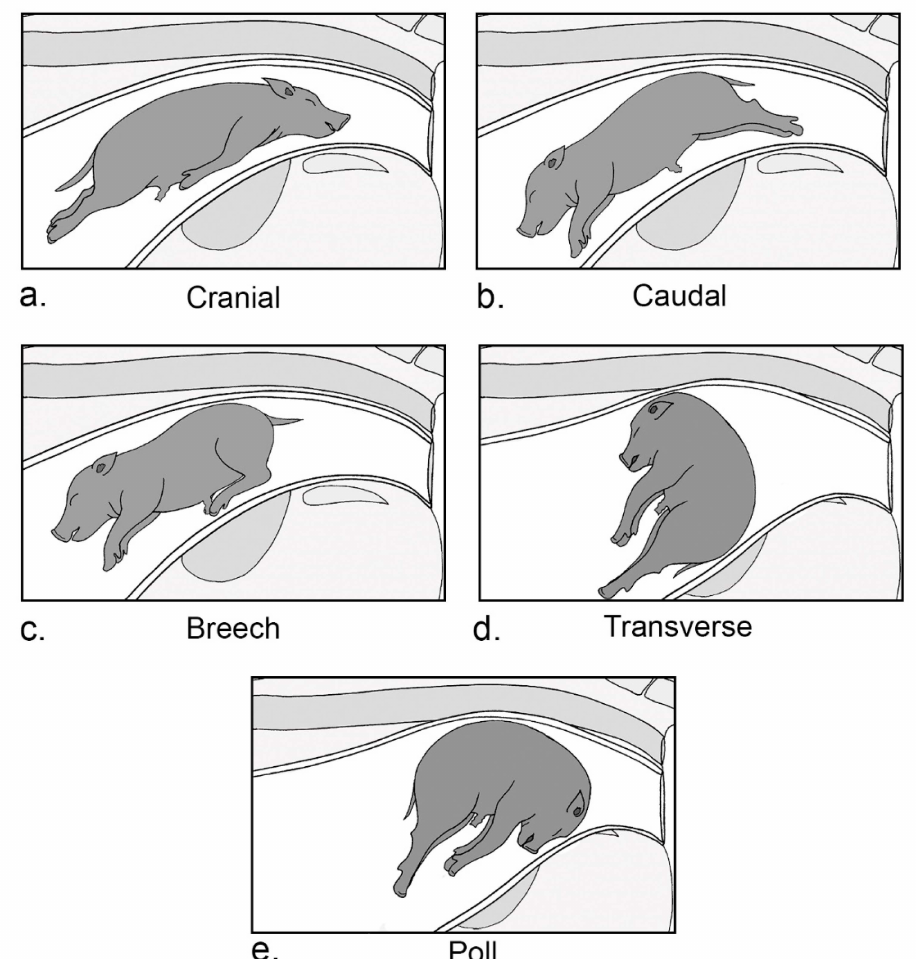
Figure 2. Anatomical piglet positioning within the birthing canal at parturition: ( a ) cranial pre- sentation involving the head exiting first and forelimbs gathered up against the body; ( b ) caudal presentation involving hindlegs first, posteriorly extended away from the body; ( c ) breech position involving the hindquarters exciting first and hindlegs flexed forward towards the body; ( d ) transverse positioning involving a sideways positioning of the body with fore- and hindlimbs exciting last; ( e ) poll presentation involving a bent neck with the head pressed against the body and snout facing towards the